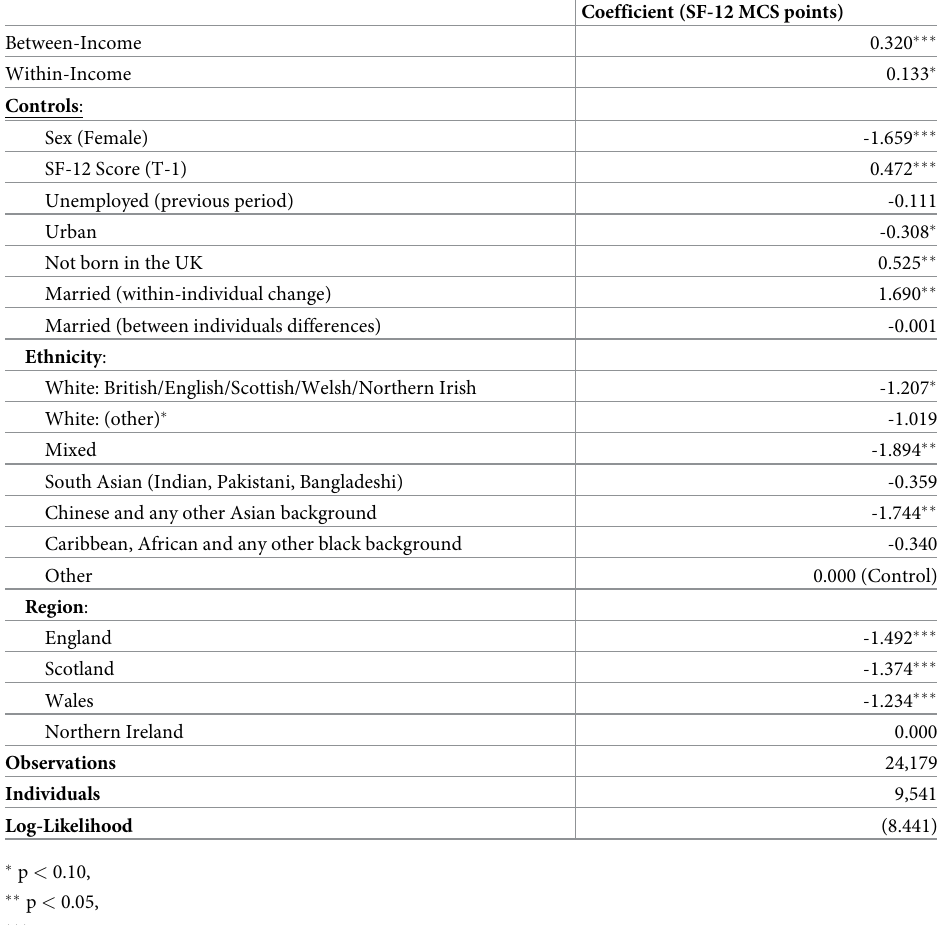
Table 5. Within-between model (Model 2): SF-12 MCS and net equivalised household income